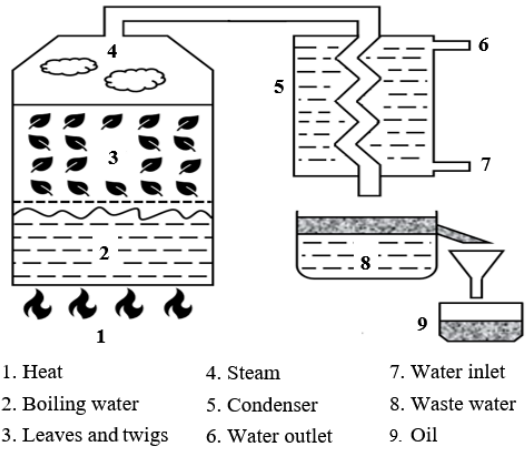
Figure 3. Water-steam distillation method.